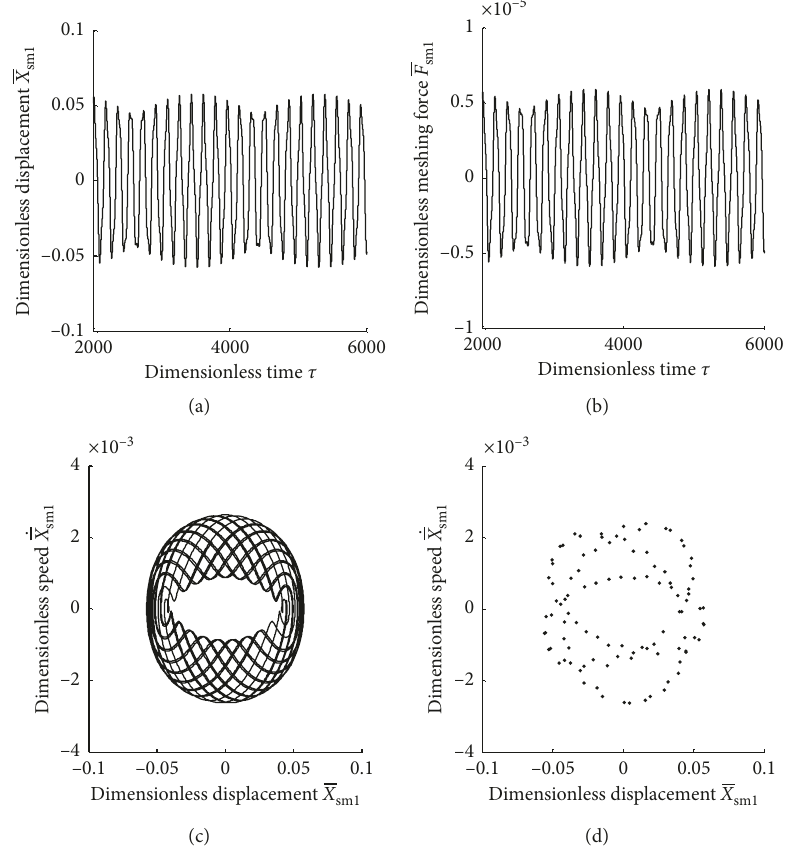
Figure 4: Process diagrams of response, phase diagram, and Poincar´e section under b � 0 μ m for encased stage. (a) Time process diagram of displacement response. (b) Time process diagram of meshing force response. (c) Phase diagram. (d) Poincar´e